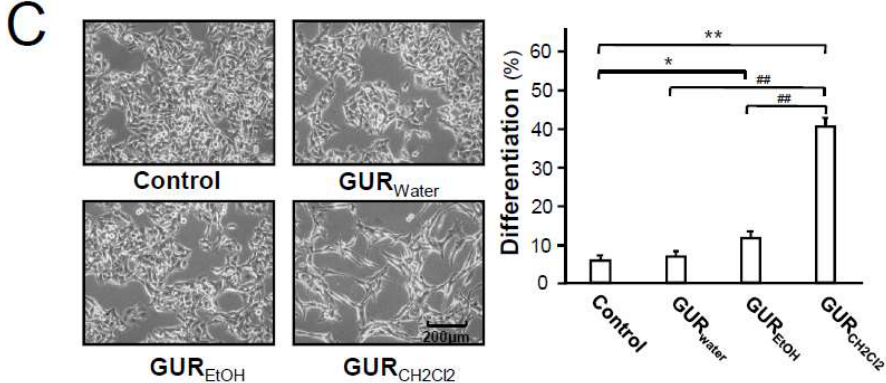
Figure 1. Effects of different extracts of G. uralensis root in antiproliferation and differentiation-inducing activities in B16-F10 cells. ( A ) HPLC chromatograms of different extracts, all at 1 mg/mL, from GUR, i.e., GU water (water extract of GUR), GU EtOH (EtOH extract of GUR), and GU CH2Cl2 (CH 2 Cl 2 extract of GUR). ( B ) Melanoma B16-F10 cells were treated with different extracts of GUR or with medium of 0.1% DMSO (dimethylsulphoxide) for 48 h, after which cells were counted under MTT (3-(4,5-dimethyl-2-thiazolyl)-2,5-diphenyl-2-H-tetrazolium bromide) assay. ( C ) Melanoma B16-F10 cells were treated with GU water , GU EtOH , and GU CH2Cl2 (50 μg/mL, respectively) for 48 h (left panel). At least 150 cells were counted for cells with dendrite longer than 3 × cellular body, as differentiated cells (right panel). Data are expressed as percentage of control, in means ± SEM of 3 independent experiments. * p < 0.05, ** p < 0.01, compared with control; ## p < 0.01, compared with other extracts.